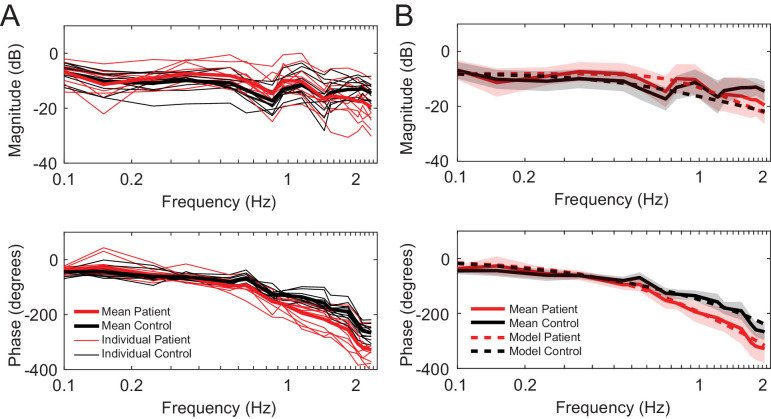
Frequency responses.(A) Individual frequency responses for the 11 control subjects (black) and 11 patients (red). It also shows the average responses for controls (black bolded) and patients (red bolded). (B) Mean responses with standard deviation for controls (black bold line with grey shaded region) and patients (red bold line with red shaded region). The simulated model frequency responses (dashed lines) match the actual mean responses well. The frequency responses of the simulated models capture qualitative features, such as the crossing of the response curves between patients and controls both in the magnitude and phase. The simulated model here is Best 4 (Lowest Err).